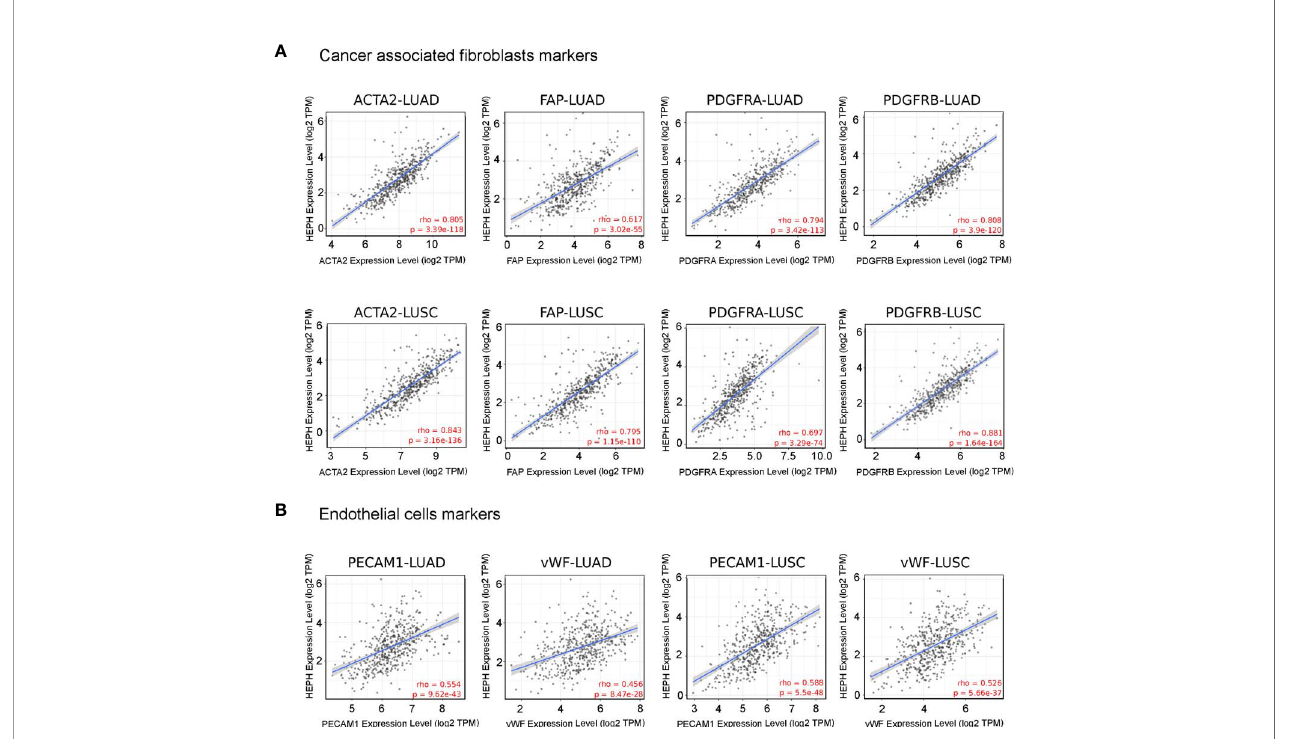
FIGURE 3 | HEPH expression positively correlated with markers of cancer-associated fi broblasts (A) and endothelial cells (B) in both LUAD and LUSC. Scatterplots of correlations between HEPH and gene markers include ACTA2, FAP, PDGFRA, PDGFRB for cancer-associated fi broblasts and PECAM1 (CD31) and vWF for endothelial